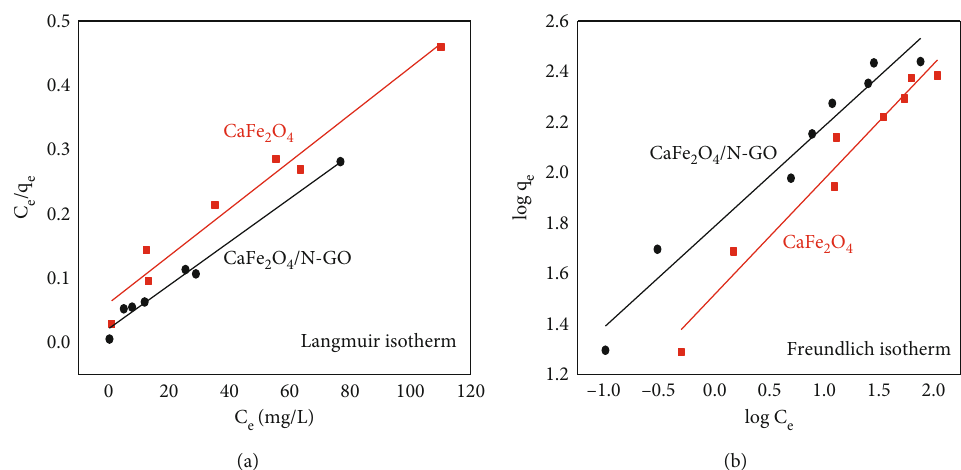
Figure 8: Fitting the experimental data to Langmuir isotherm model (a) and Freundlich isotherm model (b) for the adsorption of RO12 dye on the surface of CaFe